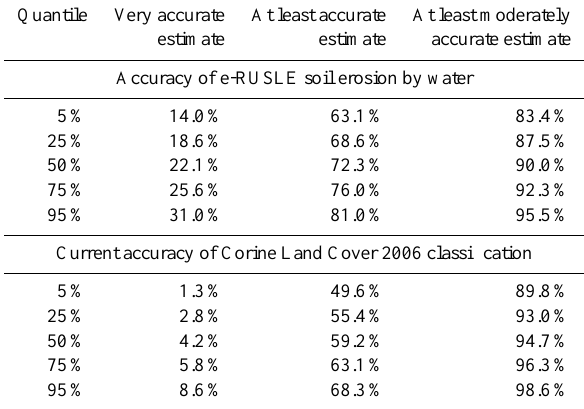
Table 3. Results of the bootstrap analysis (based on 10000 runs) of the expert-based plausibility check carried out over the 85 randomly selected clusters of 3 × 3km 2 grid cells (from Bosco et al., 2014). During the plausibility check more than 700 cells and around 10000 images were assessed. The table reports the cumulated distribution of cells which are at least moderately